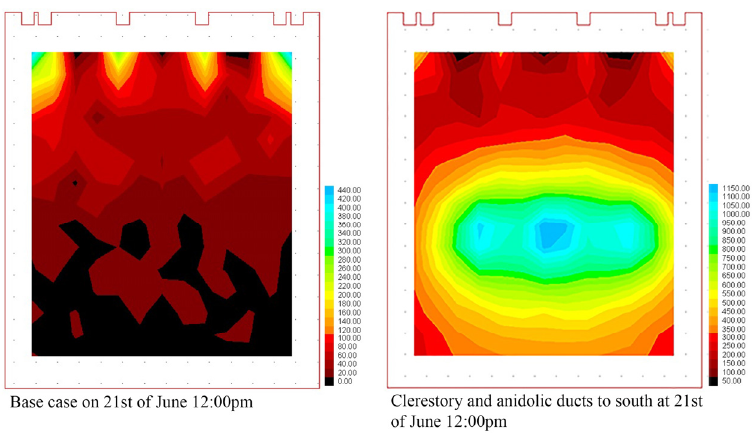
Figure 13. Illuminance level and distribution on the horizontal plane (by IES VE – FlucsDL ).